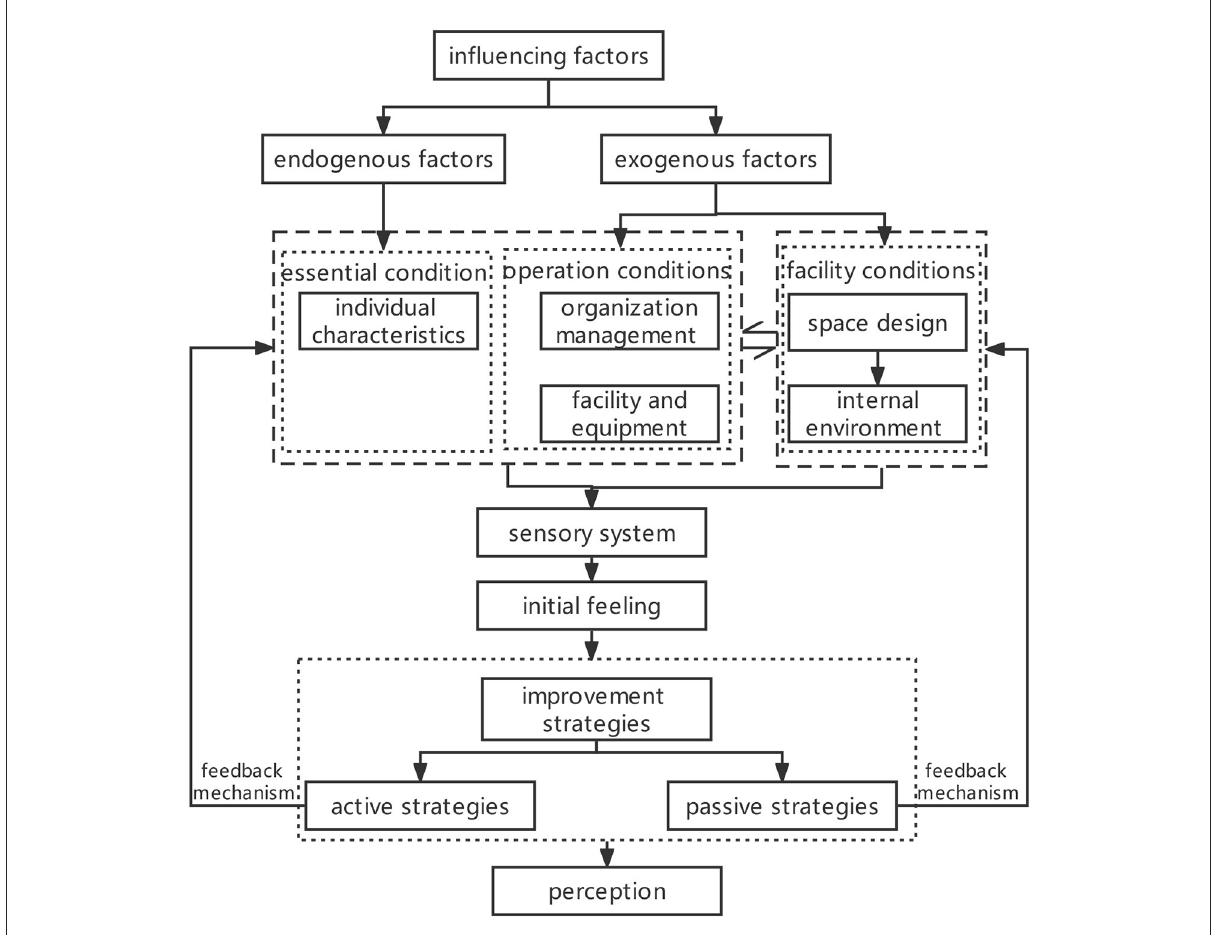
FIGURE3 Perception models of healthcare workers in